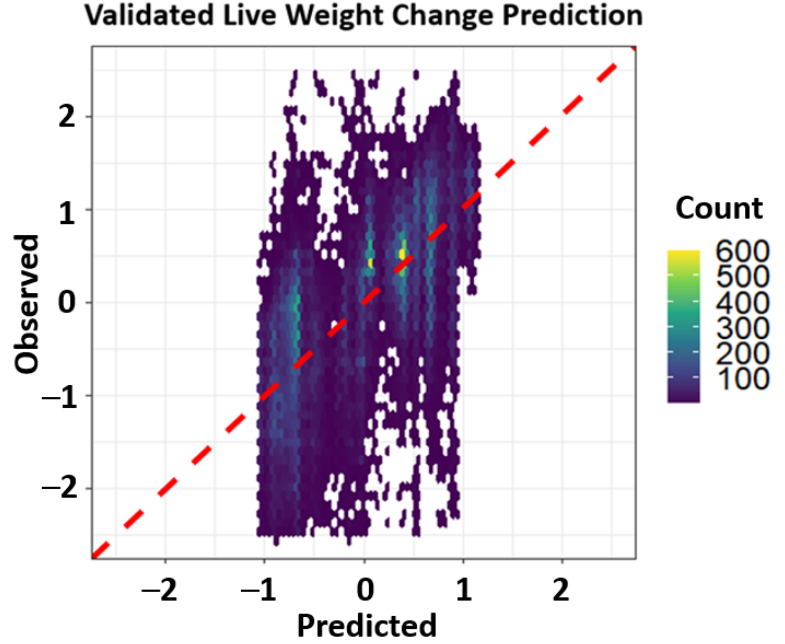
Figure 4. Observed and predicted live weight changes of breeding cows from satellite imagery, rainfall and day of the year in extensive conditions over the 2-year trial period. Table 5. Validated model statistics for machine learning model predicting live weight change of breeding cows from vegetation indices, date, and rainfall under extensive conditions.